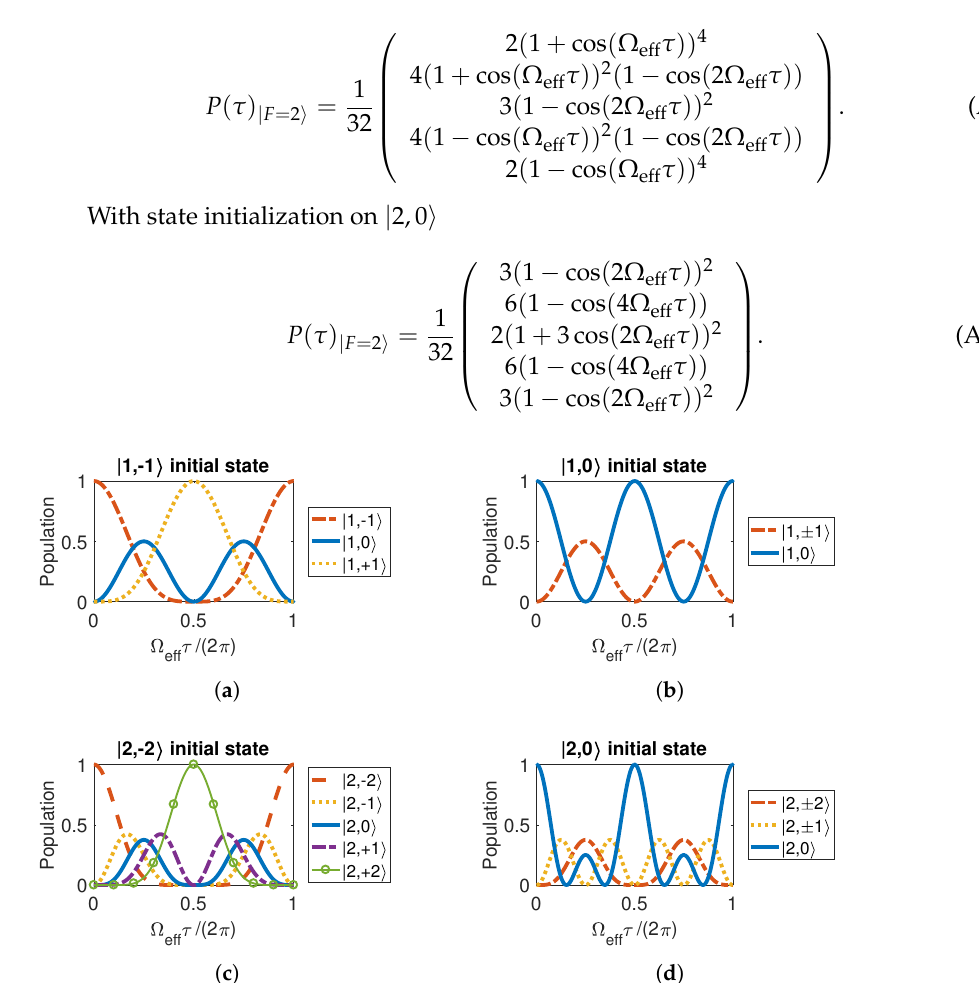
Figure A1. Rabi oscillations in the F = 1 system when the initial state is a ( a ) side state and a ( b ) center state. Rabi oscillations in the F = 2 system when the initial state is a ( c ) side state and a ( d ) center